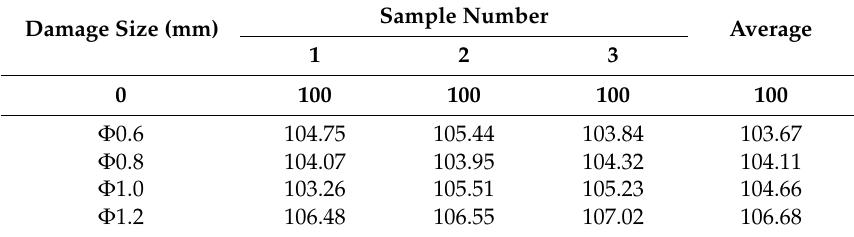
Table 5. Normalized ultrasonic energy dissipation coefficient of damage category D2 (unit: %).